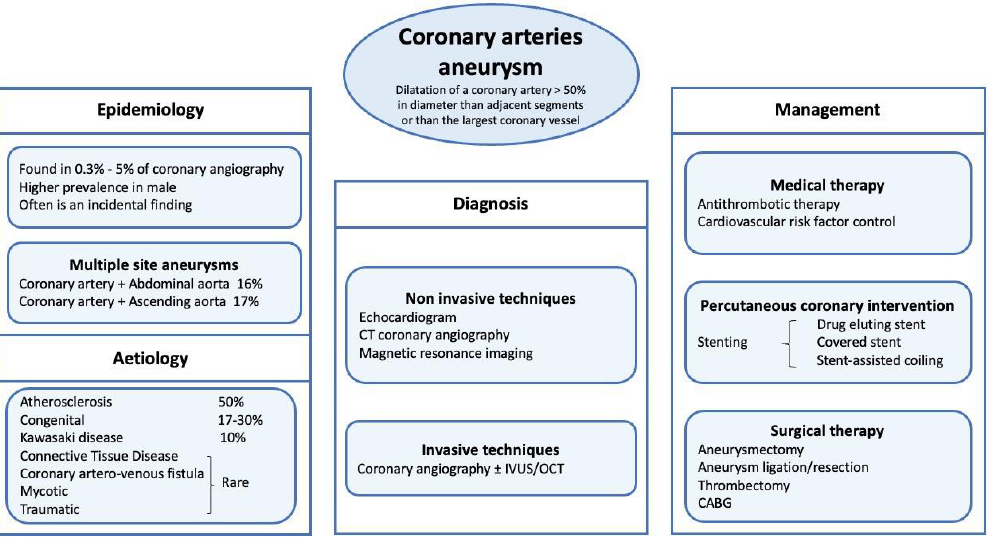
Figure 1. Coronary Artery Aneurysm management. CT (coronary tomography); CABG (coronary artery bypass graft); IVUS (IntraVascular UltraSound); OCT (Optical coherence tomography).